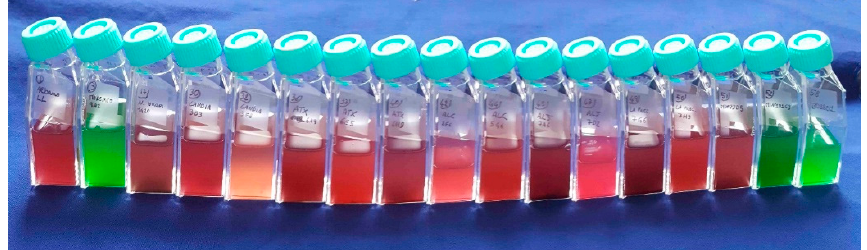
Figure 4. Cultures of 17 freshwater strains of Synechococcus with different pigments that show the diversity in pigment composition with different pink, yellowish, and green colours (from [26], mod- ified).